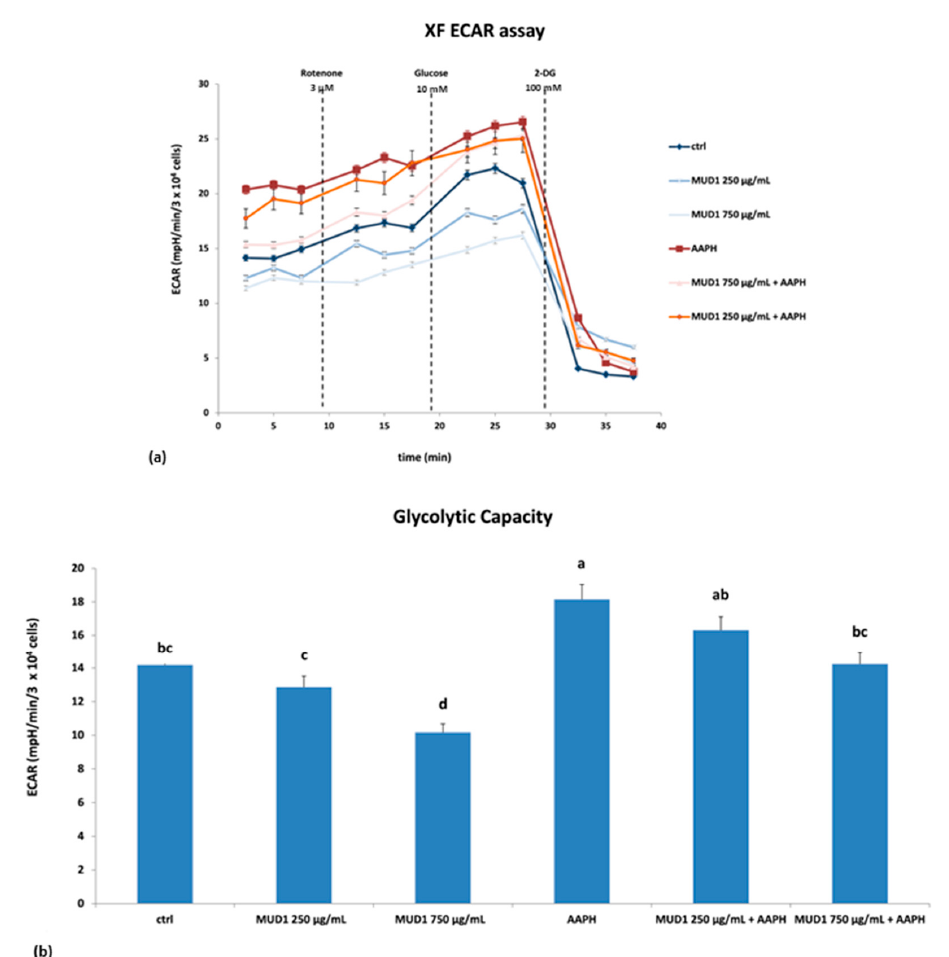
Figure 6. Extracellular acidification rate (ECAR) ( a ) and glycolytic capacity ( b ) in HDF cells treated with different concentrations of MUD1 (250–750 µg/mL) for 24 h, AAPH (10 mM) for 24 h and with different concentrations of MUD1 and then with AAPH. Data are expressed as mean values ± SD. Columns belonging to the same set of data with different superscript letters are significantly different ( p < 0.05).